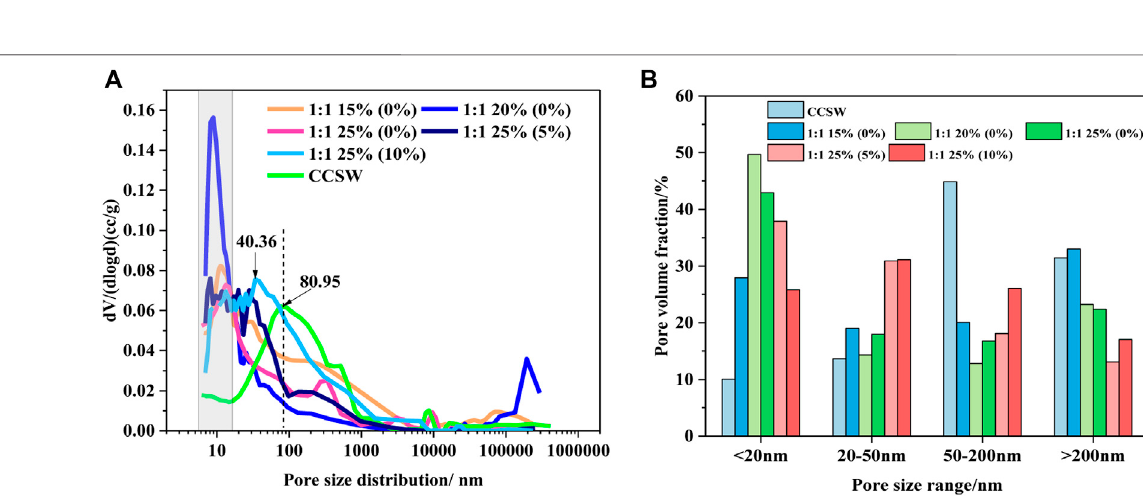
Frontiers in Materials |